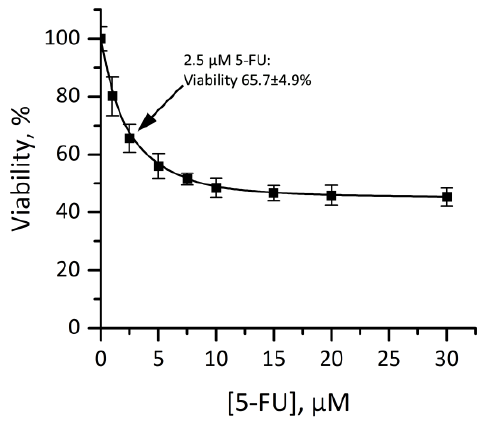
Figure 6. Cytotoxicity of 5-FU towards HeLa cells after 72 h incubation. The concentration marked with an arrow was chosen for combination experiments with dendriplexes. Data are presented as Mean ± Standard Deviation. n for each concentration = 18, n of untreated control = 72.